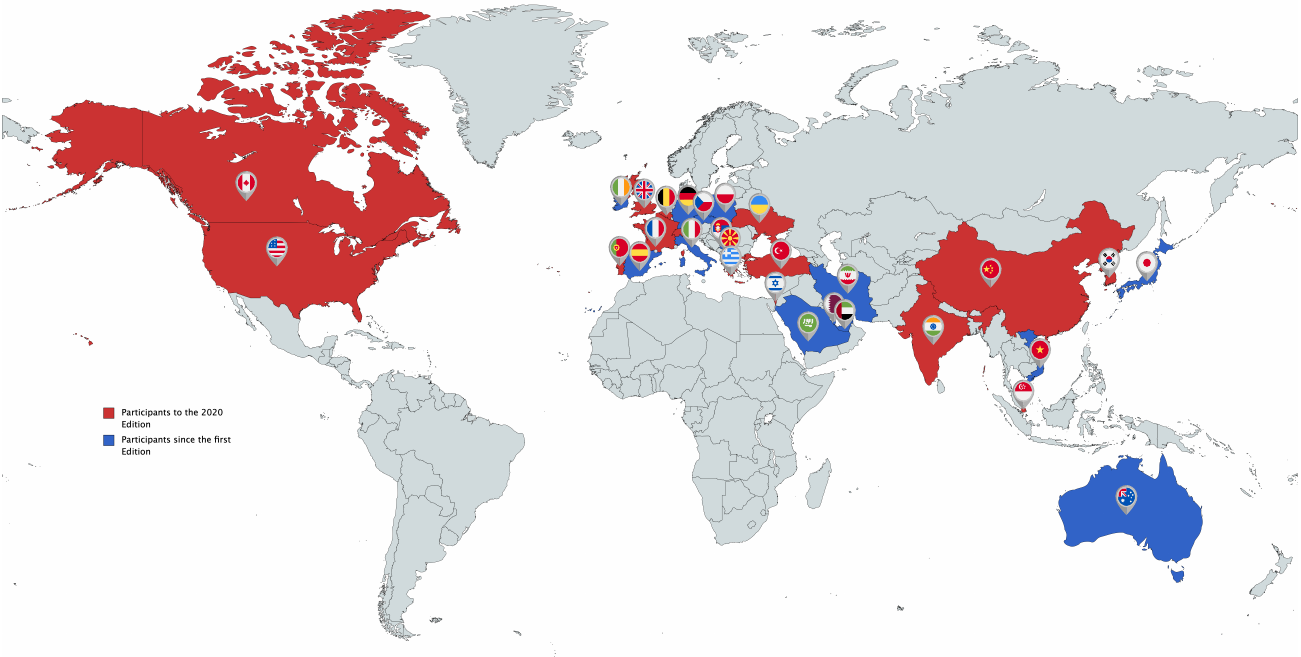
Figure 5. Research groups that participated to the Drone vs. Bird Challenge up to March